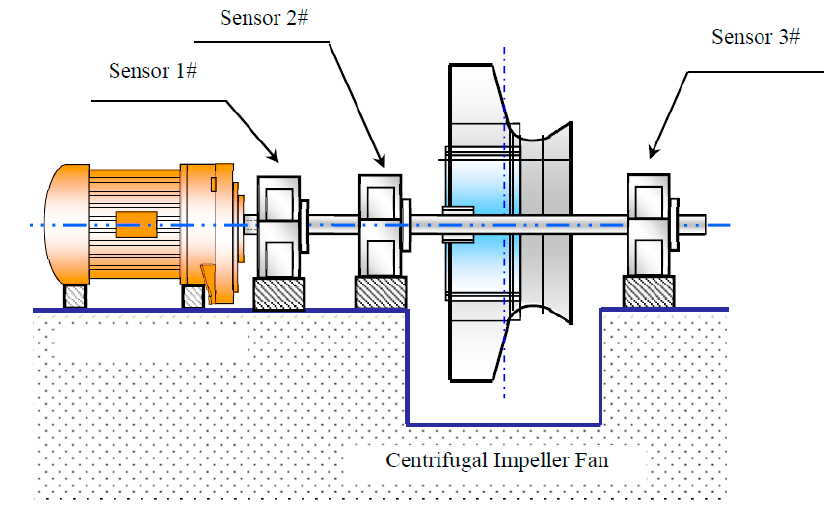
Figure 18. Mechanical transmission chain of the booster fan (from the driving AC motor to the centrifugal compressor).